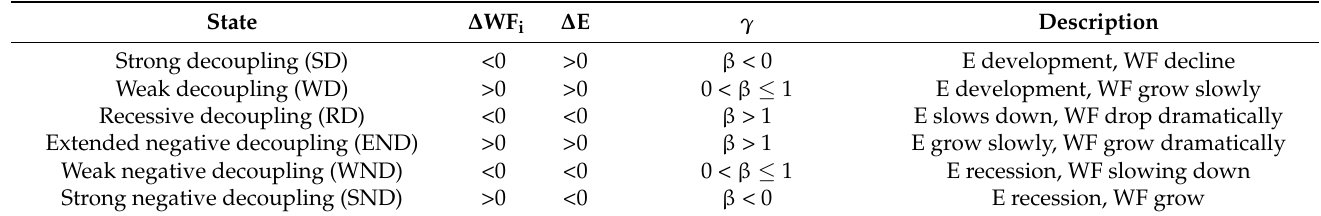
Table 1. Judgment standard of decoupling